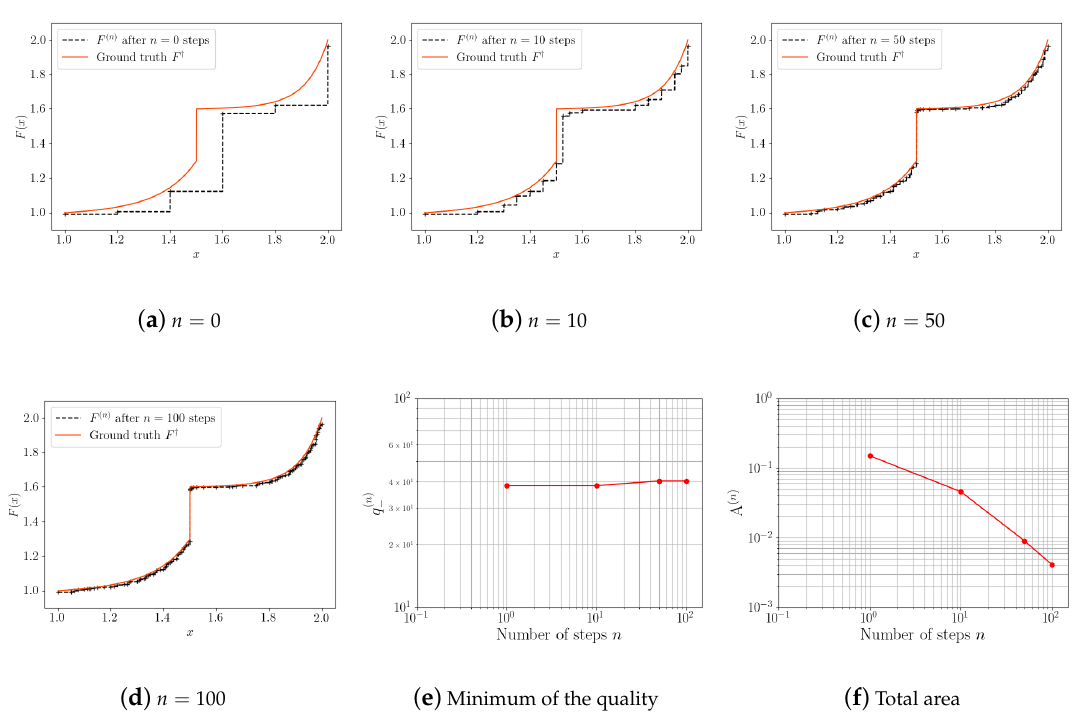
Figure 5. Evolution of F ( n ) and the minimum of the quality and the total area as functions of the iteration count, n , for a discontinuous ground truth F † with E = 10 − 4 .